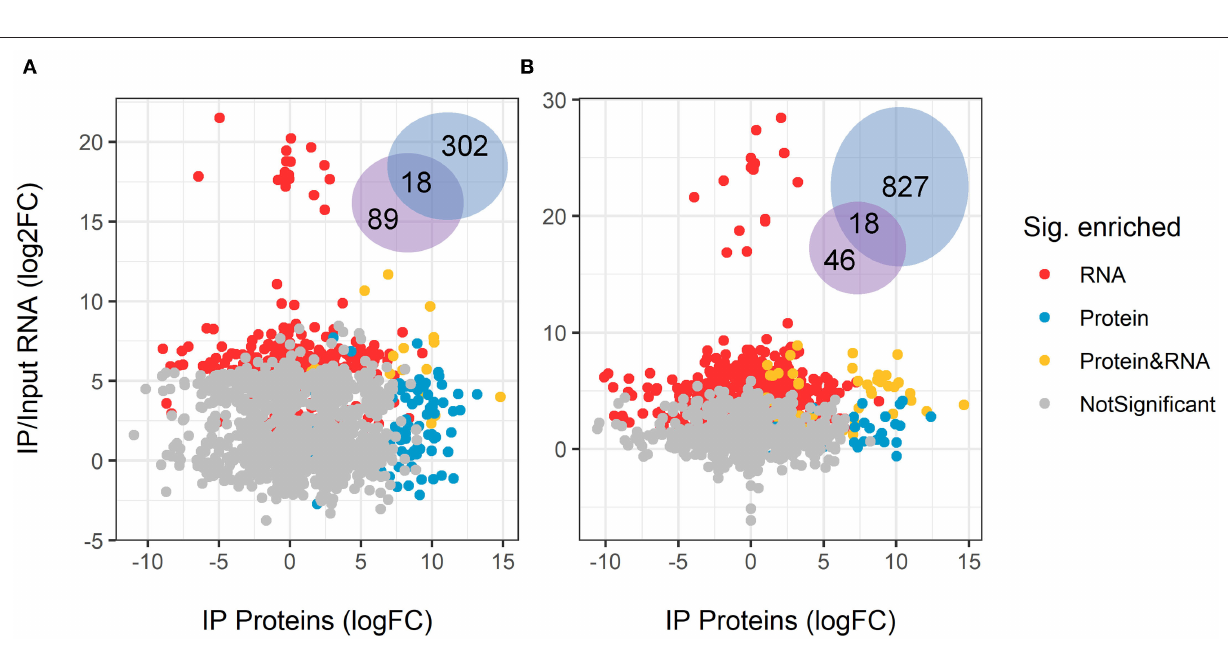
FIGURE 4 | Overlap between enriched GUL-1-immunoprecipitated RNA transcripts and proteins. The log 2 fold-change of GFP-GUL-1 IP proteins was compared to the enriched RIP RNAseq in (A) standard growth conditions (Vs), and (B) Nikkomycin Z treatments. No correlation was found for the protein profile and the RNASeq enrichment. Only matching pairs of proteins and RNA transcripts are displayed, when both were detected in the subsequent analysis. The Venn diagram shows the number of shared and uniquely enriched genes or